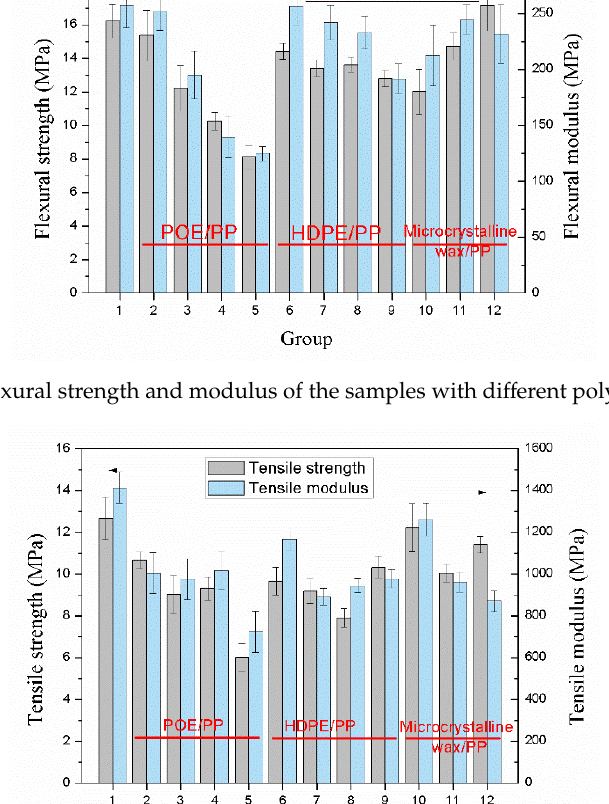
Figure 9. Tensile strength and modulus of the samples with different polymer blends.